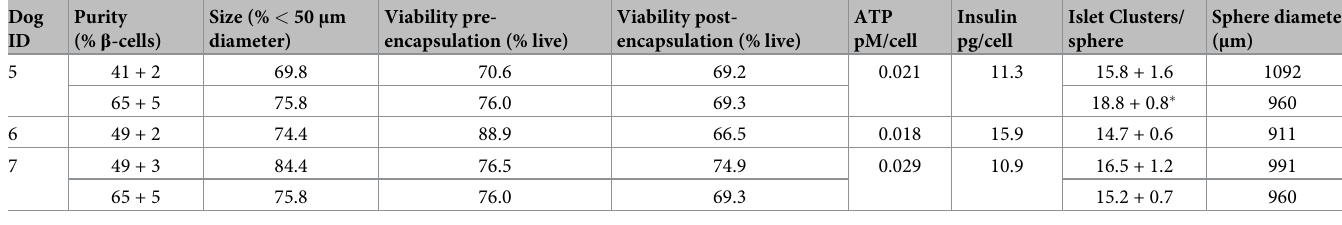
Table 2. Islet characteristics for efficacy study.